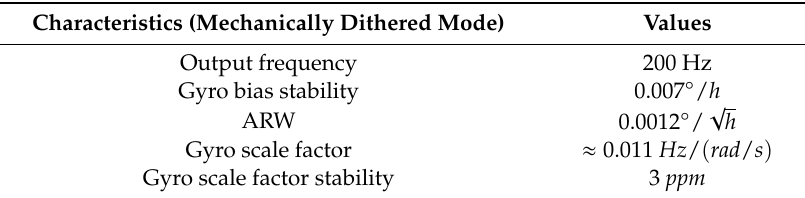
Table 1. Specifications of RLG.